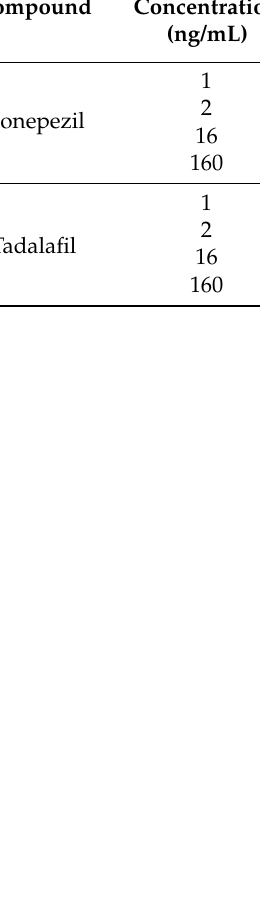
Table 2. Stability of donepezil and tadalafil stock solutions in rat plasma under different